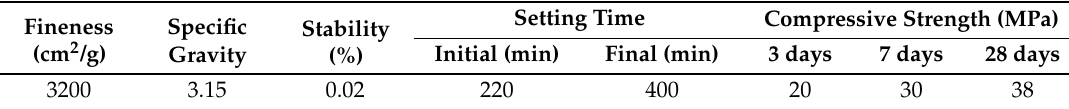
Table 1. Properties of